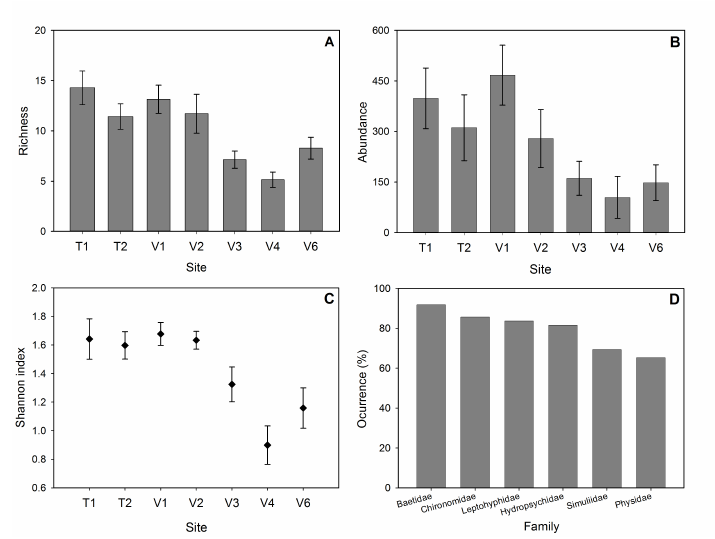
Figure 3. Benthic macroinverbrate indexes per site in the Virilla river. ( A ) Richness. ( B ) Abundance. ( C ) Shannon index. ( D ) occurrence of major families.